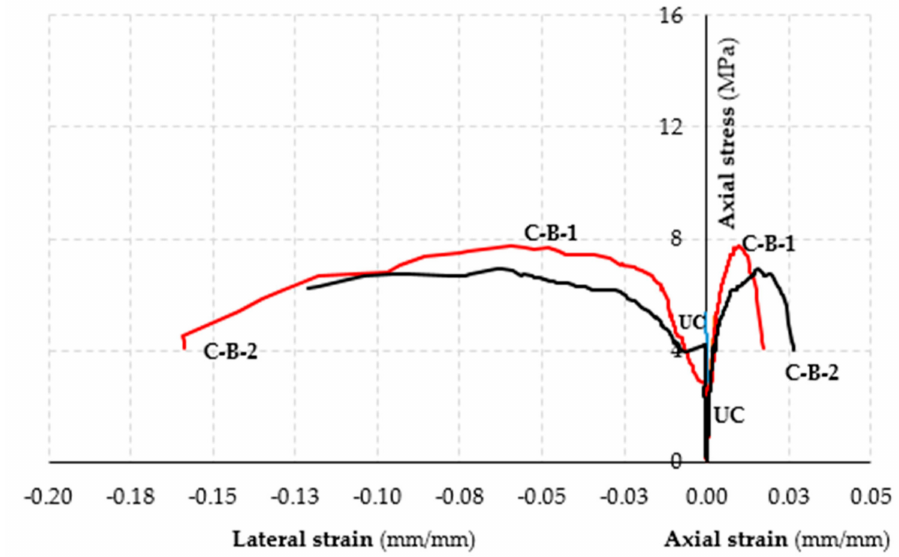
Figure 15. Axial stress -strain curves for basalt-FRCM confined columns.